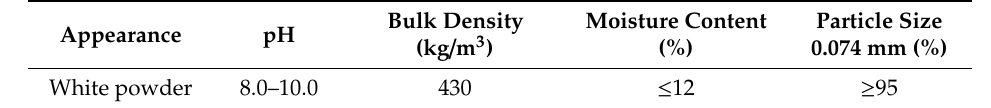
Table 6. Properties of viscosity-modifying agent.